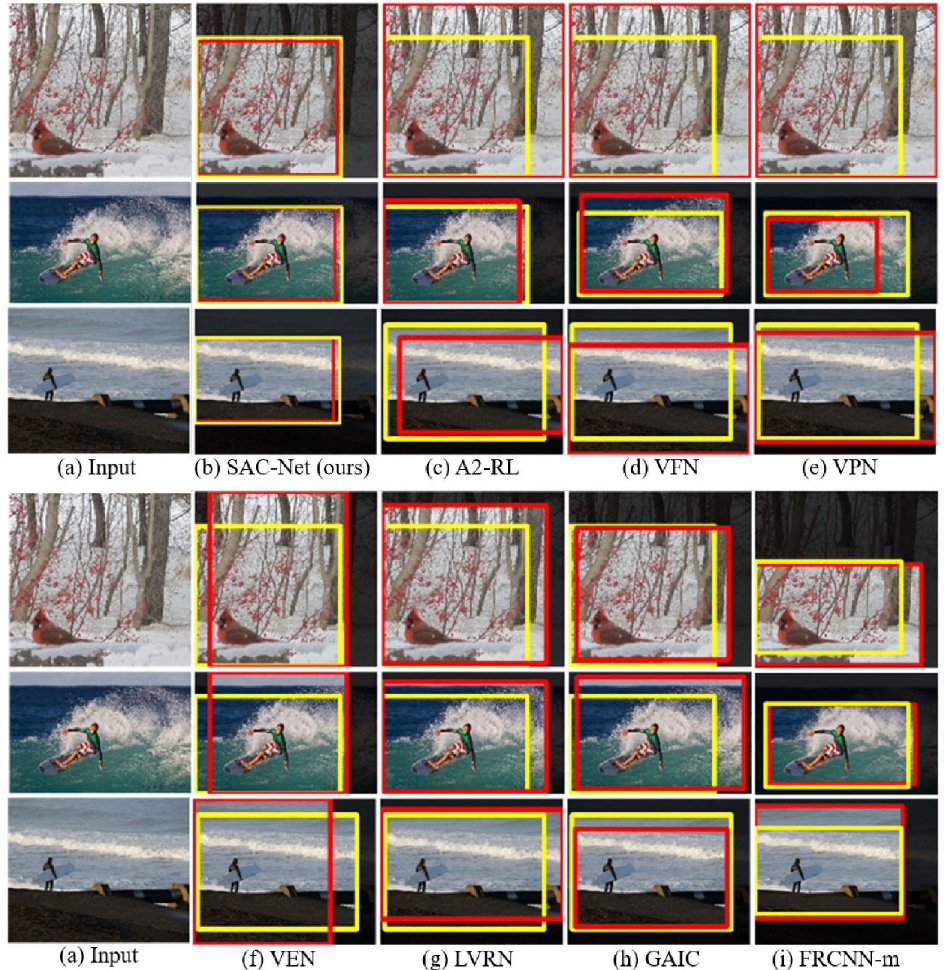
Fig. 6 Results using the SACD dataset test set. We compare our method to 7 other methods (c)–(i). Red box: best cropping window for a method. Yellow box: one of the 8 ground truth windows, with highest IoU to the red